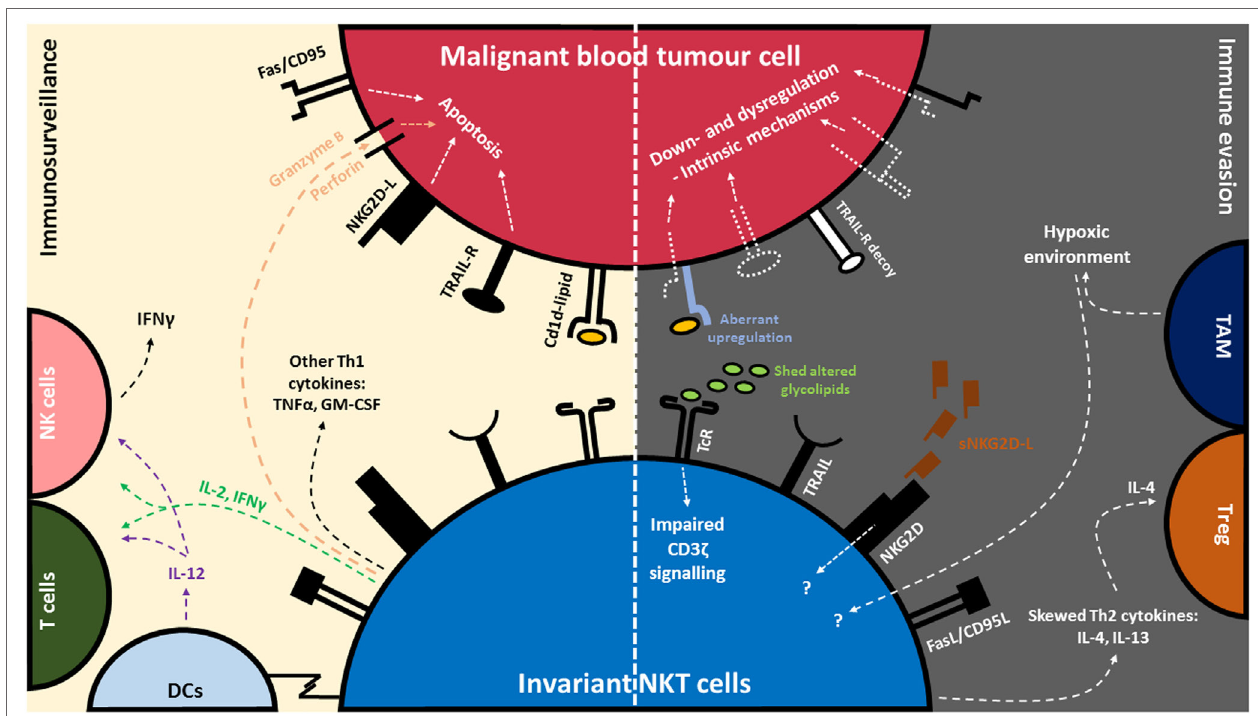
FiGURe 1 | Invariant natural killer T (iNKT) cell-mediated immune surveillance of blood cancer and counteractive evasion strategies utilized by blood cancer cells. (Left) iNKT cells recognize glycolipid antigens presented on CD1d, commonly expressed by blood tumor cells. Recognition of glycolipid:CD1d complex via the invariant T cell receptor (TcR) leads to a cascade of events: the production of immunomodulatory cytokines such as interleukin-2 (IL-2), interferon- γ (IFN γ ), tumor necrosis factor- α (TNF α ), and granulocyte-macrophage colony-stimulating factor (GM-CSF), release of cytolytic mediators such as perforin/granzyme, activation of antigen-presenting cells (APCs) such as dendritic cells (DCs) and IL-12 production, as well as the rapid transactivation of NK cells and T cells. iNKT cells can also recognize tumor and degranulate in a CD1d-independent manner via Natural Killer Group 2D ( NKG2D) receptors. (Right) In turn, tumor cells can evade recognition and killing by downregulating CD1d, NKG2D-L, TNF-related apoptosis-inducing ligand (TRAIL-L) and FAS/CD95. In addition, certain blood tumors can disrupt death signaling pathways to avoid killing. Some blood tumors express aberrant levels of glycolipids or shed soluble glycolipids and NKG2D-L which in turn dysregulate normal signaling pathway in iNKT cells. Blood tumors cells can also skew the production of Th2 cytokines (IL-4 and IL-13) in iNKT cells. IL-4 is associated with the activation of regulatory T cells (Treg) which are involved in dampening of antitumor responses. Dysfunction of iNKT cells have also been associated with tumor- associated macrophages (TAMs) and their ability to induce hypoxia in the tumor